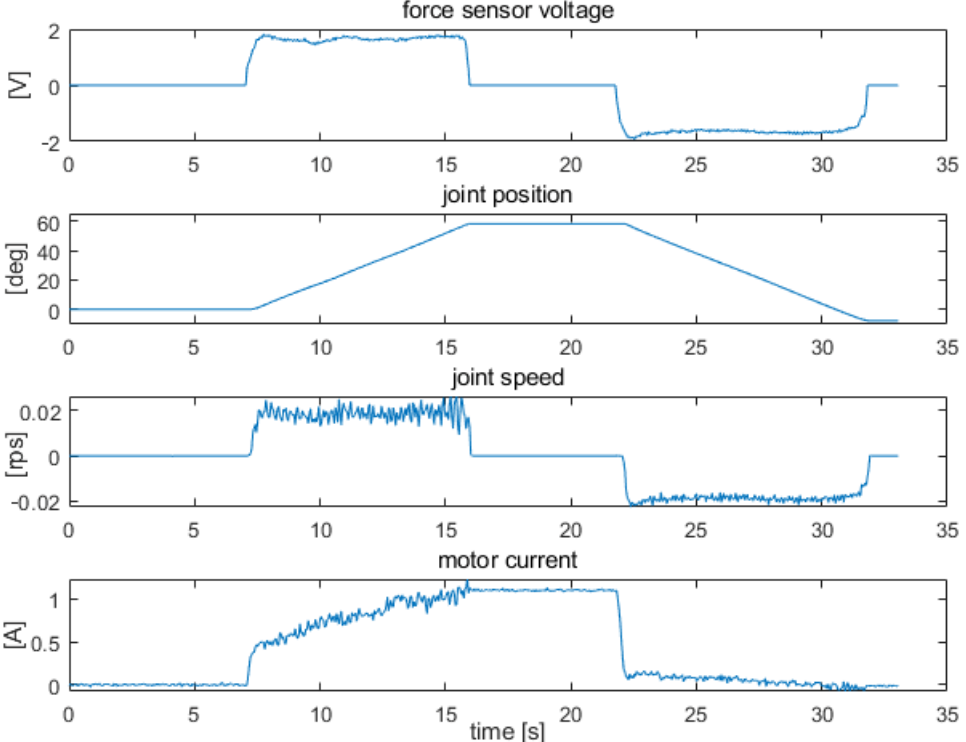
Figure 11. Signal waveforms from force, position, speed, and supply current sensors for elbow joint drive under uneven force on the sensors.